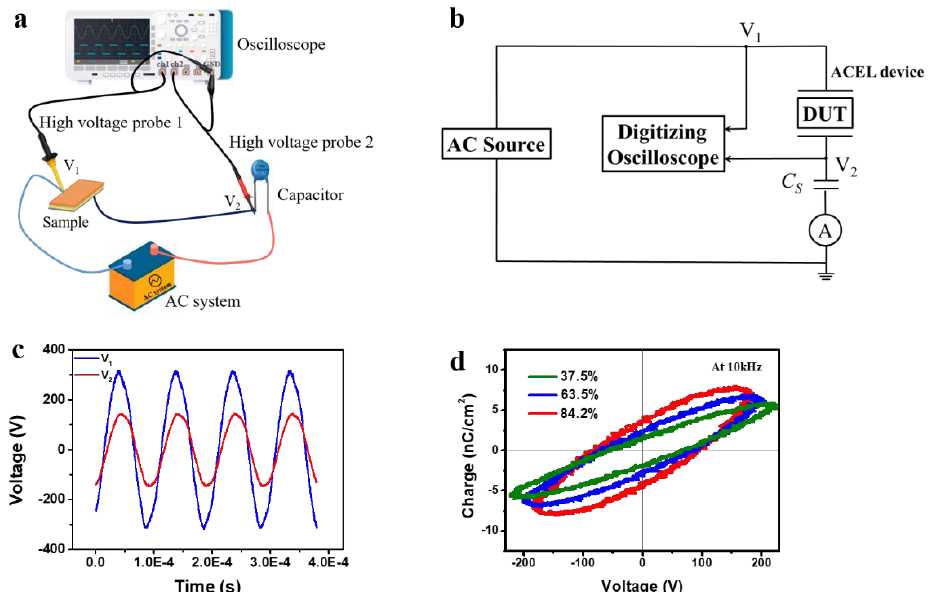
Figure 5. ( a ) Electrical characterization setup and the ( b ) equivalent electric circuit diagram. ( c ) Voltage waveform recorded during the test. ( d ) A family of 𝑄~𝑉 curves for paper-based ACELs driven at 10 kHz. Table 1. Analytic results of the family of 𝑄~𝑉 curves.